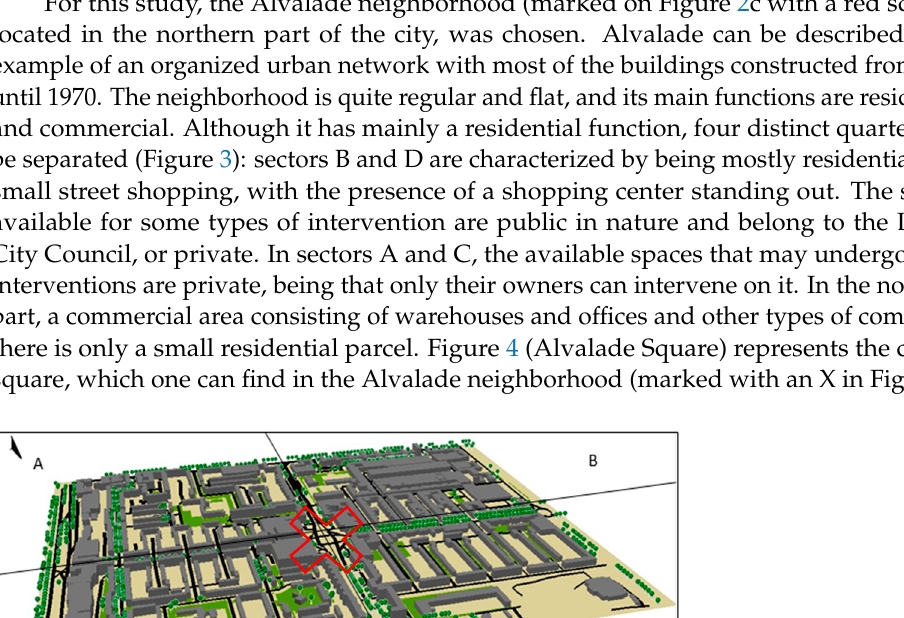
Figure 2. Study area framing map. AML = Lisbon Metropolitan Area (a).